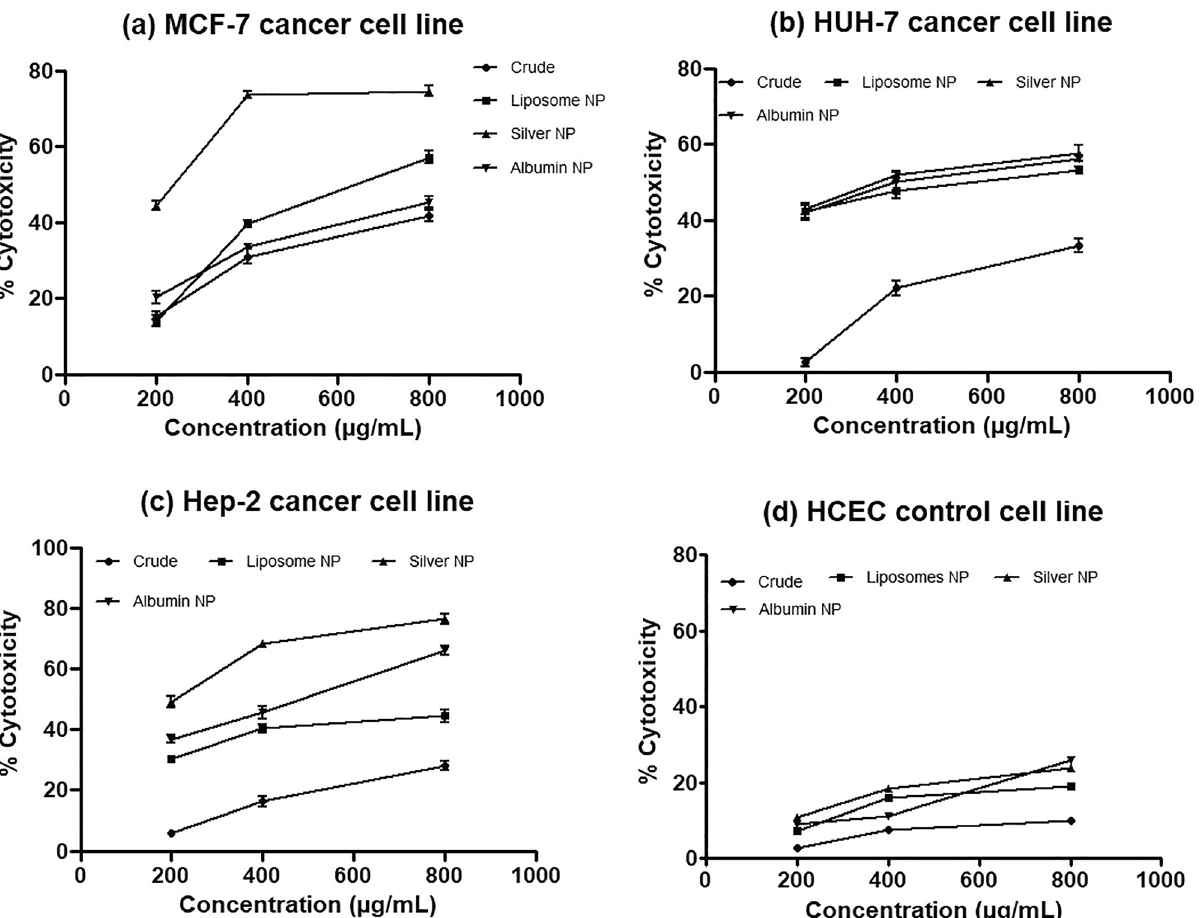
Figure 4. Anti cancer activity (detemined by MTT cell viability assay) of F. cretica plant extract and their NPs against ( a ) MCF-7 ( b ) HUH-7 ( c ) Hep-2 and ( d ) HCEC cell lines. Data represented as mean ± SD of three independent